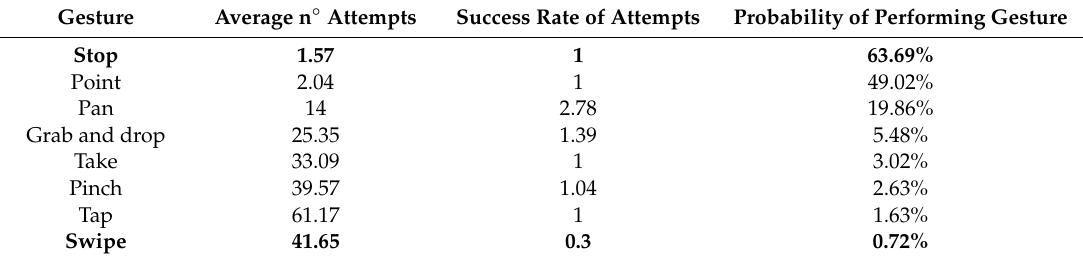
Table 10. Geometric distribution of probability of performing gesture on first attempt for individuals with DS.